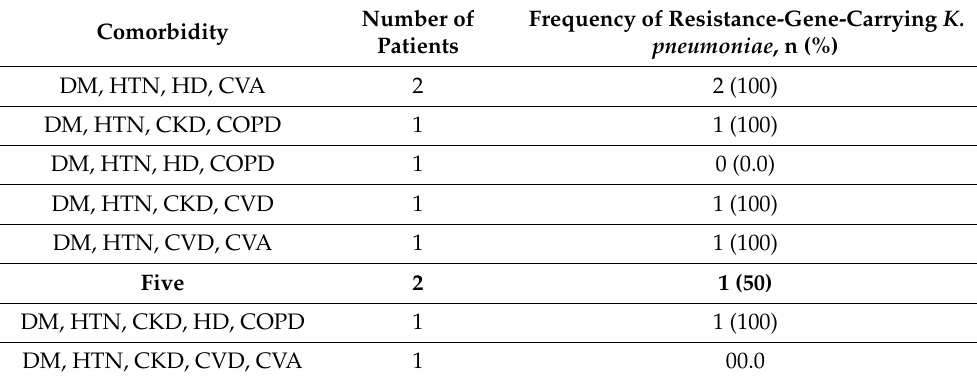
Table 3. Cont. Comorbidity